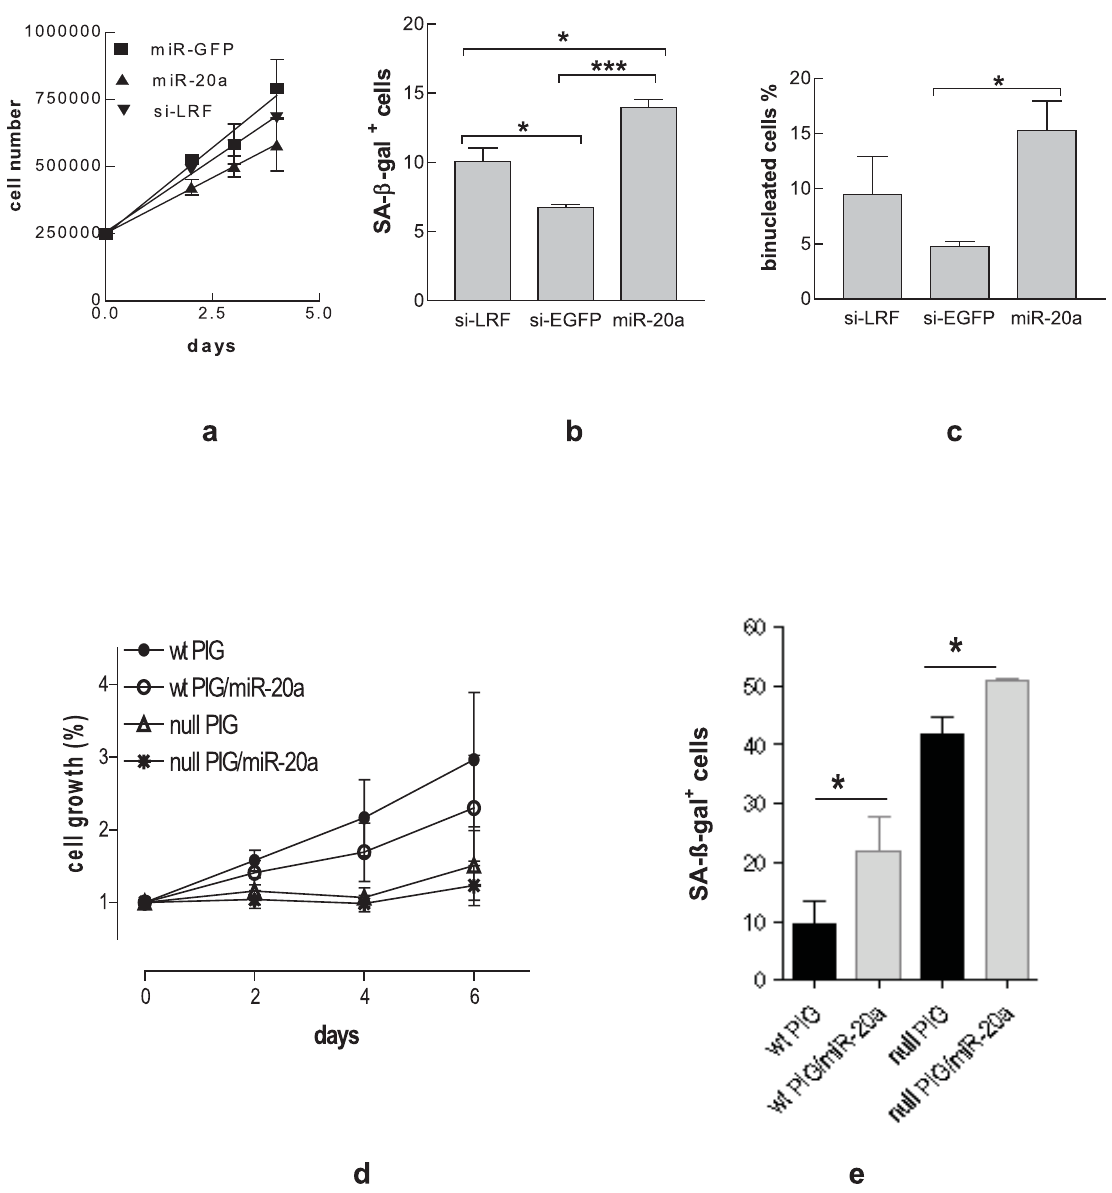
Figure 3. miR-20a induces senescence in MEF. Detection of cell proliferation (a) , SA-ß-gal positive (b) and binucleated (c) cells in wt MEF transfected with miR-20a. Detection of proliferation (d) and SA-ß-gal positive (e) cells in wt and LRF-null MEF retrovirally infected with PIG/miR-20a. Each bar represents the mean 6 SE of three independent experiments.